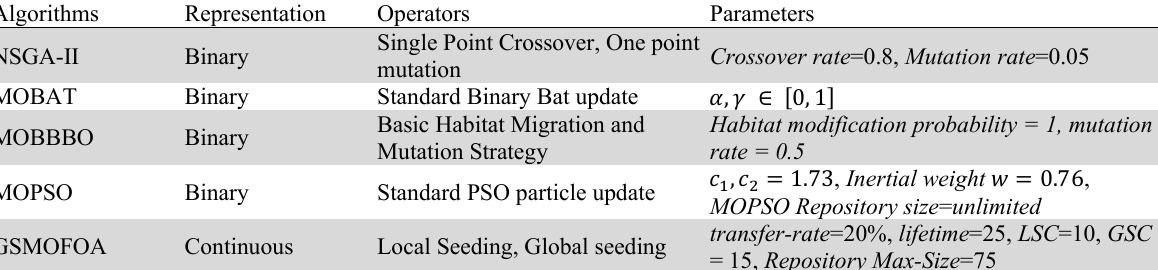
Summary of the parameters and settings of the compared algorithms Algorithms